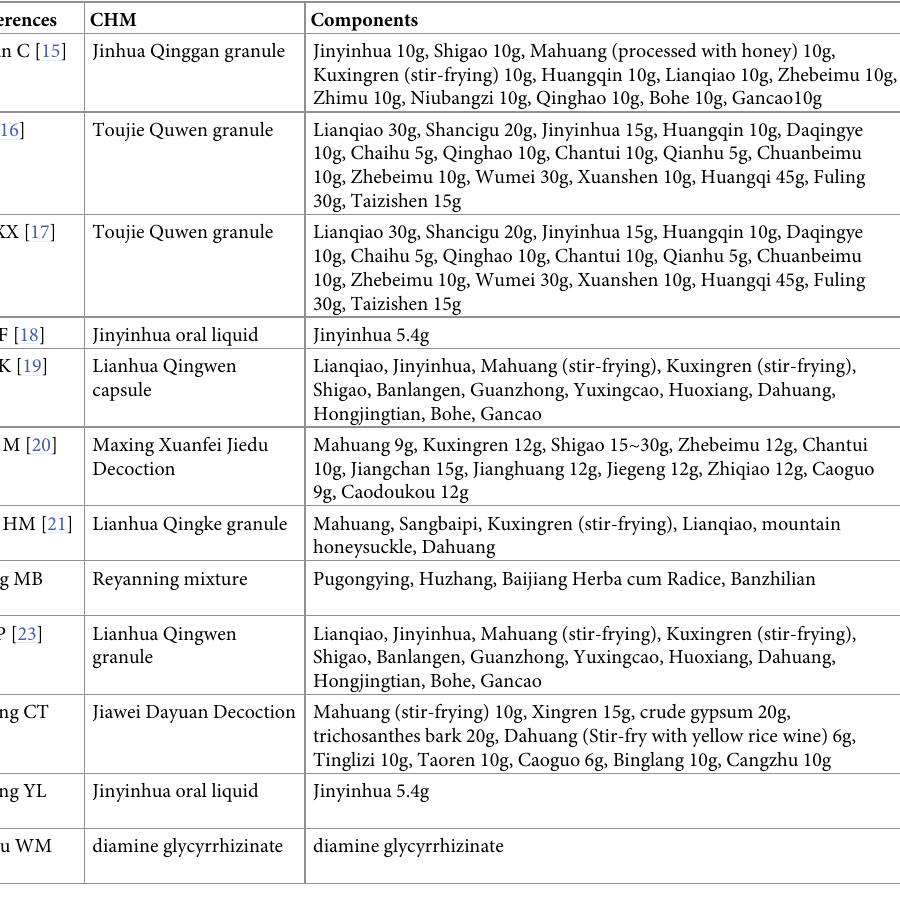
Clinical symptoms. Fever . Three trials enrolling 205 patients mentioned fever reduction cases [15, 21, 25]. A random-effects model was used due to the significant heterogeneity ( I 2 = 95%, P < 0.00001). Meta-analysis showed that there was no statistical difference on fever reduc-